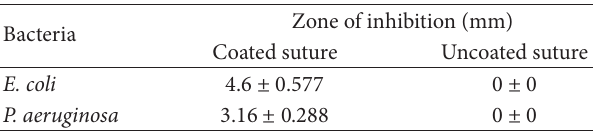
Table 1: In vitro testing of coated and uncoated sutures against E. coli and P. aeruginosa .